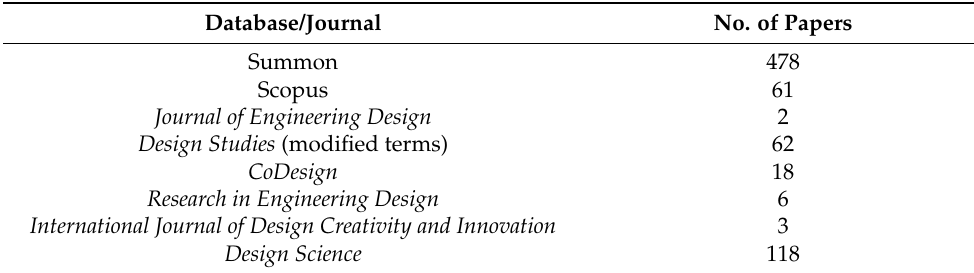
Table 2. Table outlining the databases and search terms